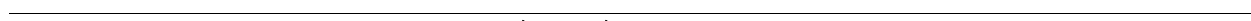
Figure 2 | IL-12 induces eNK cells in lungs of naive Rag2 (cid:2) / (cid:2) Il2rg (cid:2) / (cid:2) mice. ( a ) Representative plots and absolute numbers of CD45 þ CD3 (cid:2) CD122 þ CD49b þ cells in lungs from IL-12 or Fc-treated (Ctrl) WT or Rag2 (cid:2) / (cid:2) Il2rg (cid:2) / (cid:2) mice. The expression of NK1.1 on CD45 þ CD3 (cid:2) CD122 þ CD49b þ cells in lungs from IL-12 or Ctrl-treated WT or Rag2 (cid:2) / (cid:2) Il2rg (cid:2) / (cid:2) mice is shown. Data represent five experiments ( n Z 4 mice per group per experiment). ( b ) Cytospin ( (cid:3) 100) of sorted CD45 þ CD3 (cid:2) CD122 þ CD49b þ cells from lungs of IL-12-treated WT or Rag2 (cid:2) / (cid:2) Il2rg (cid:2) / (cid:2) mice stained